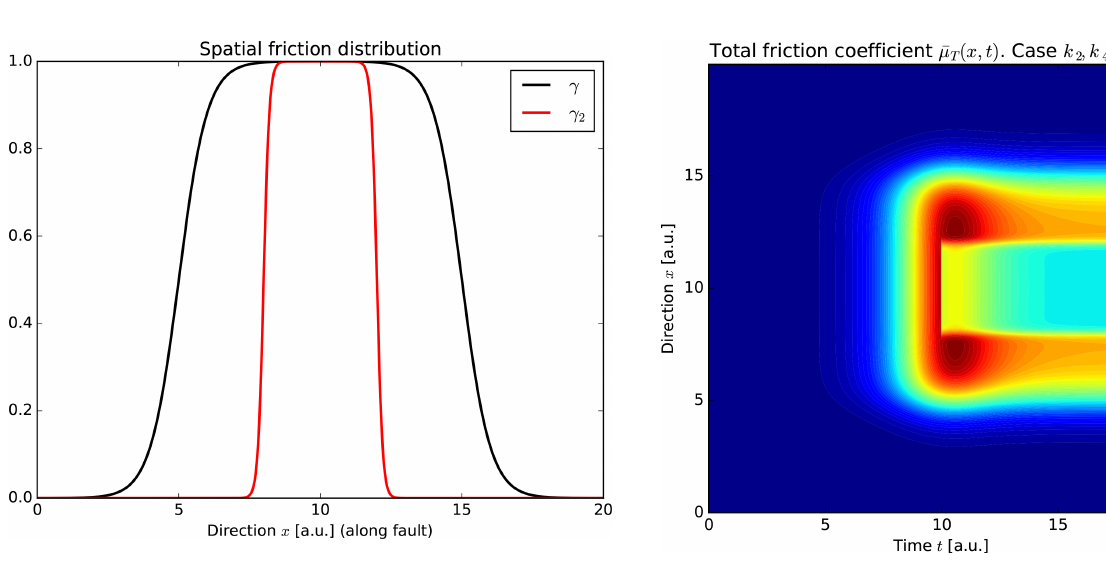
Figure 8. Spatial–temporal total friction coefficient µ T (x,t) along the fault x direction using k 2 = k 4 = 10 − 9 . The righthand color bar indicate the friction coefficient values at a certain time and